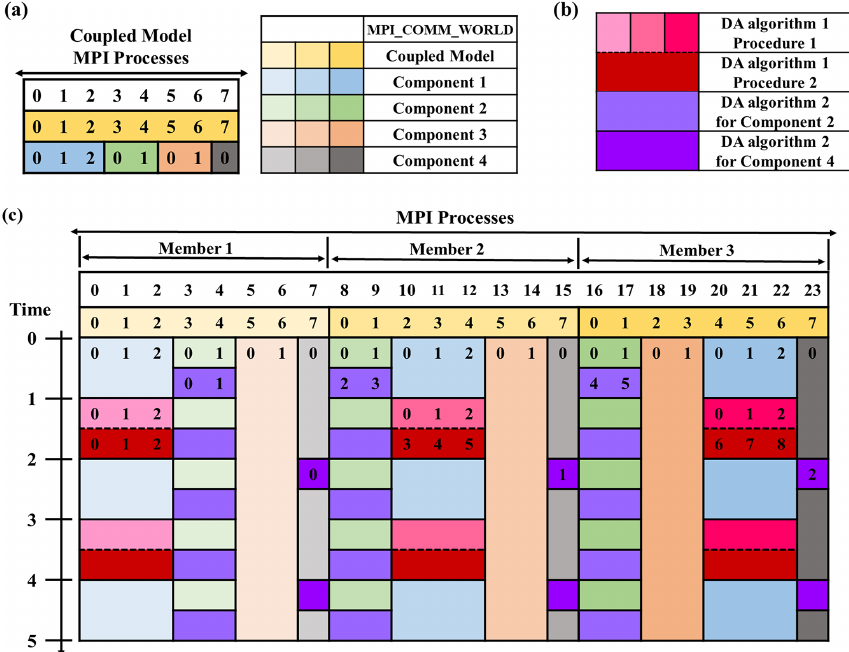
Figure 3. Example of running a DAFCC1-based weakly coupled ensemble DA system with three ensemble members. (a) Each ensemble member of the coupled model (yellow series) uses eight MPI processes, where component 1 (blue series) uses three MPI processes, com- ponent 2 (green series) uses two MPI processes, component 3 (orange series) uses two MPI processes and component 4 (gray series) uses one MPI process. (b) DA algorithm 1 and two instances of DA algorithm 2 (purple series) are used in this DA system, where DA algorithm 1 includes procedure 1 (pink series) and procedure 2 (red). (c) Execution of the DA system: the process layout of ensemble members of component models, the process layout of DA algorithms, and the alternative execution of a DA algorithm and the corresponding component model. Each number in the colored box in (a) and (c) indicates the process ID in the corresponding local communicator of a member of the coupled model, a member of a component model or all members of a component model.